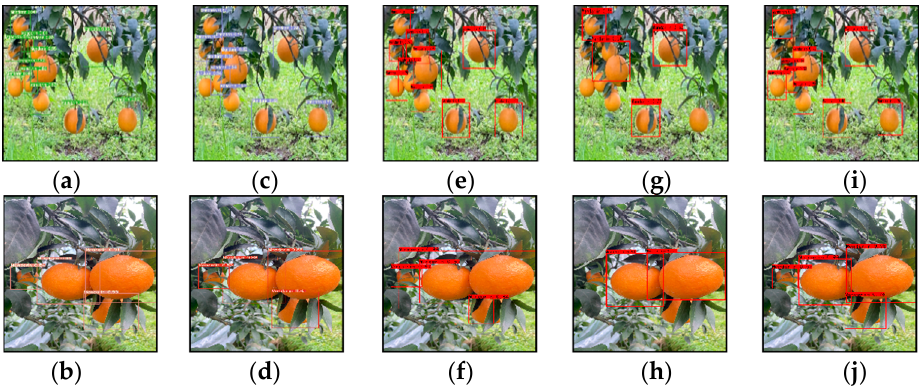
Figure 12. Test results of five models. ( a-b ) Citrus-YOLOv7; ( c-d ) YOLOv7; ( e-f ) Faster R-CNN; ( g- h ) SSD; ( i-g )